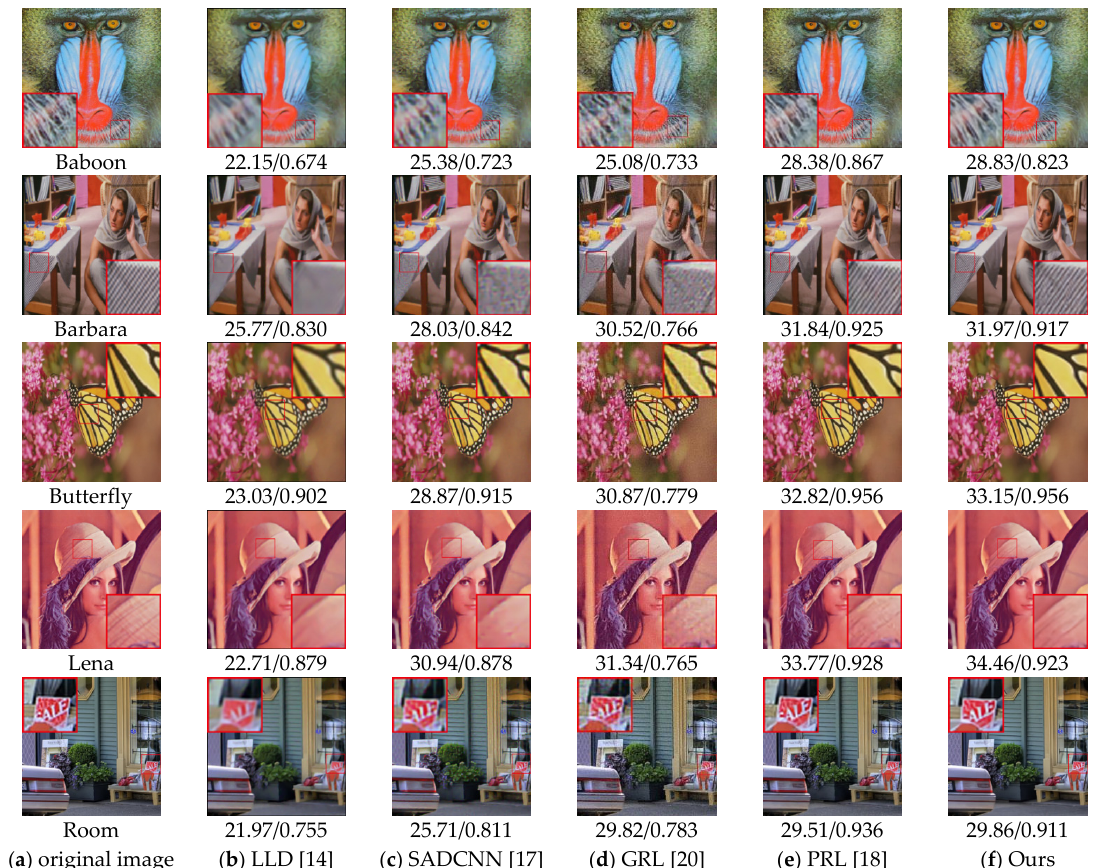
Figure 6. Comparison with state-of-the-art methods. For quantitative comparison, PSNR/SSIM are given. To further show the advantages of our proposed method compared with the previous methods, we demonstrate some restored image details, lines and texture in Figures 7–9. In Figure 7, the results of SADCNN [17] lack of texture details, but our approach describes the image details more accurately.